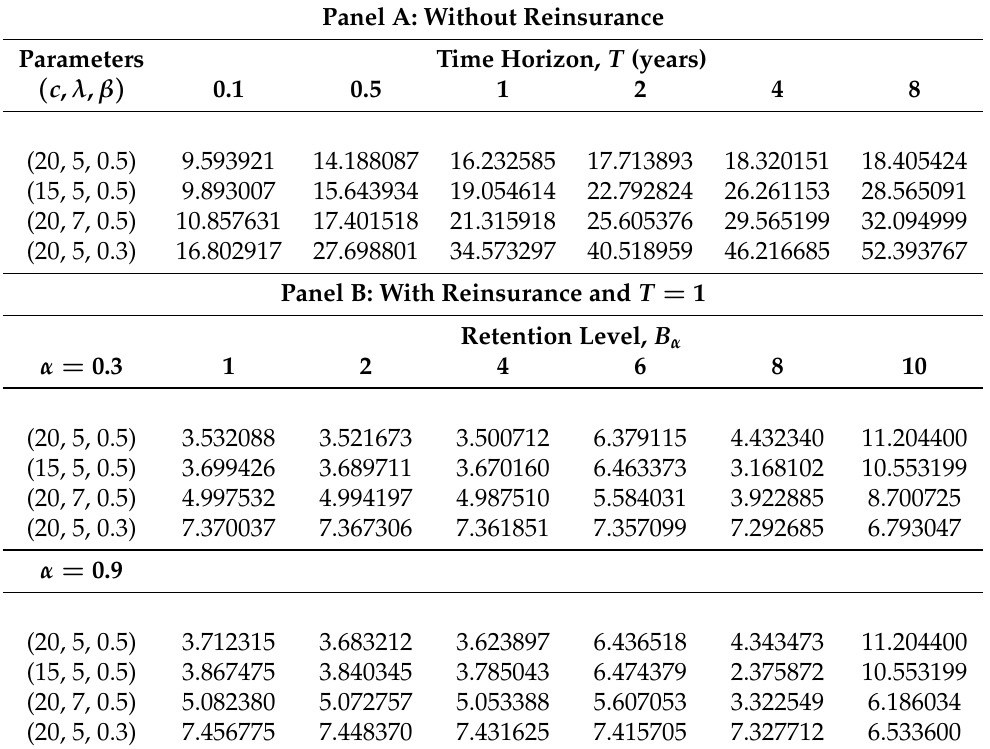
Table 3. Initial capital corresponding to a 0.5% ruin probability for different parameter values of the risk process. For the parameters, c is the insurer premium rate, λ is the claim intensity, 1/ β is the mean claim size, and α is the reinsurer premium rate. Panel A: Without Reinsurance Parameters